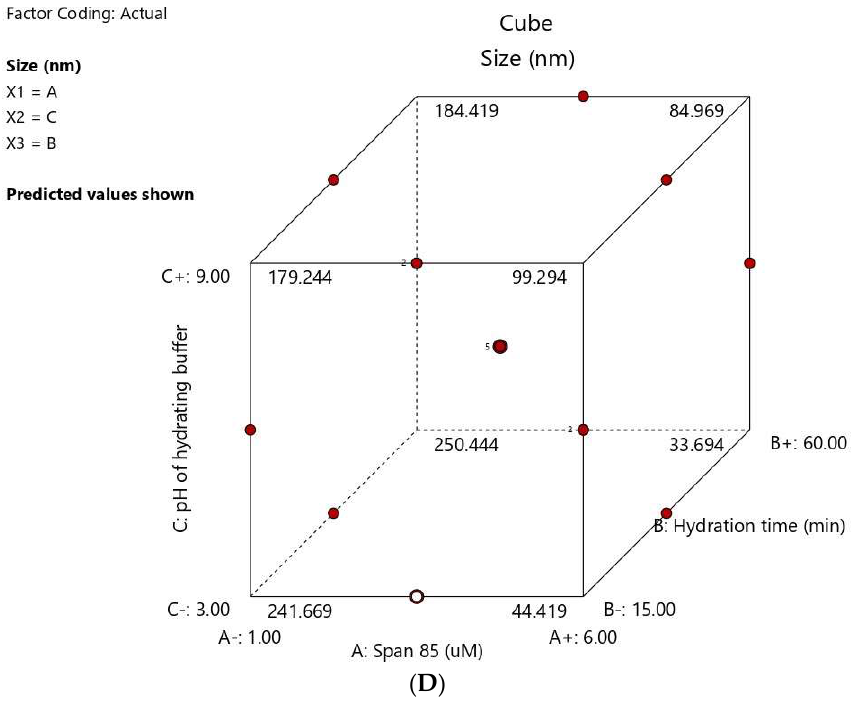
Figure 3. Response 3D plots ( A , B, and C ) and cube plot ( D ) for the effect of Span ® 85 concentration (X 1 ), Hydration time (X 2 ), and hydrating buffer pH (X 3 ) on the vesicle size of FLB niosomes.